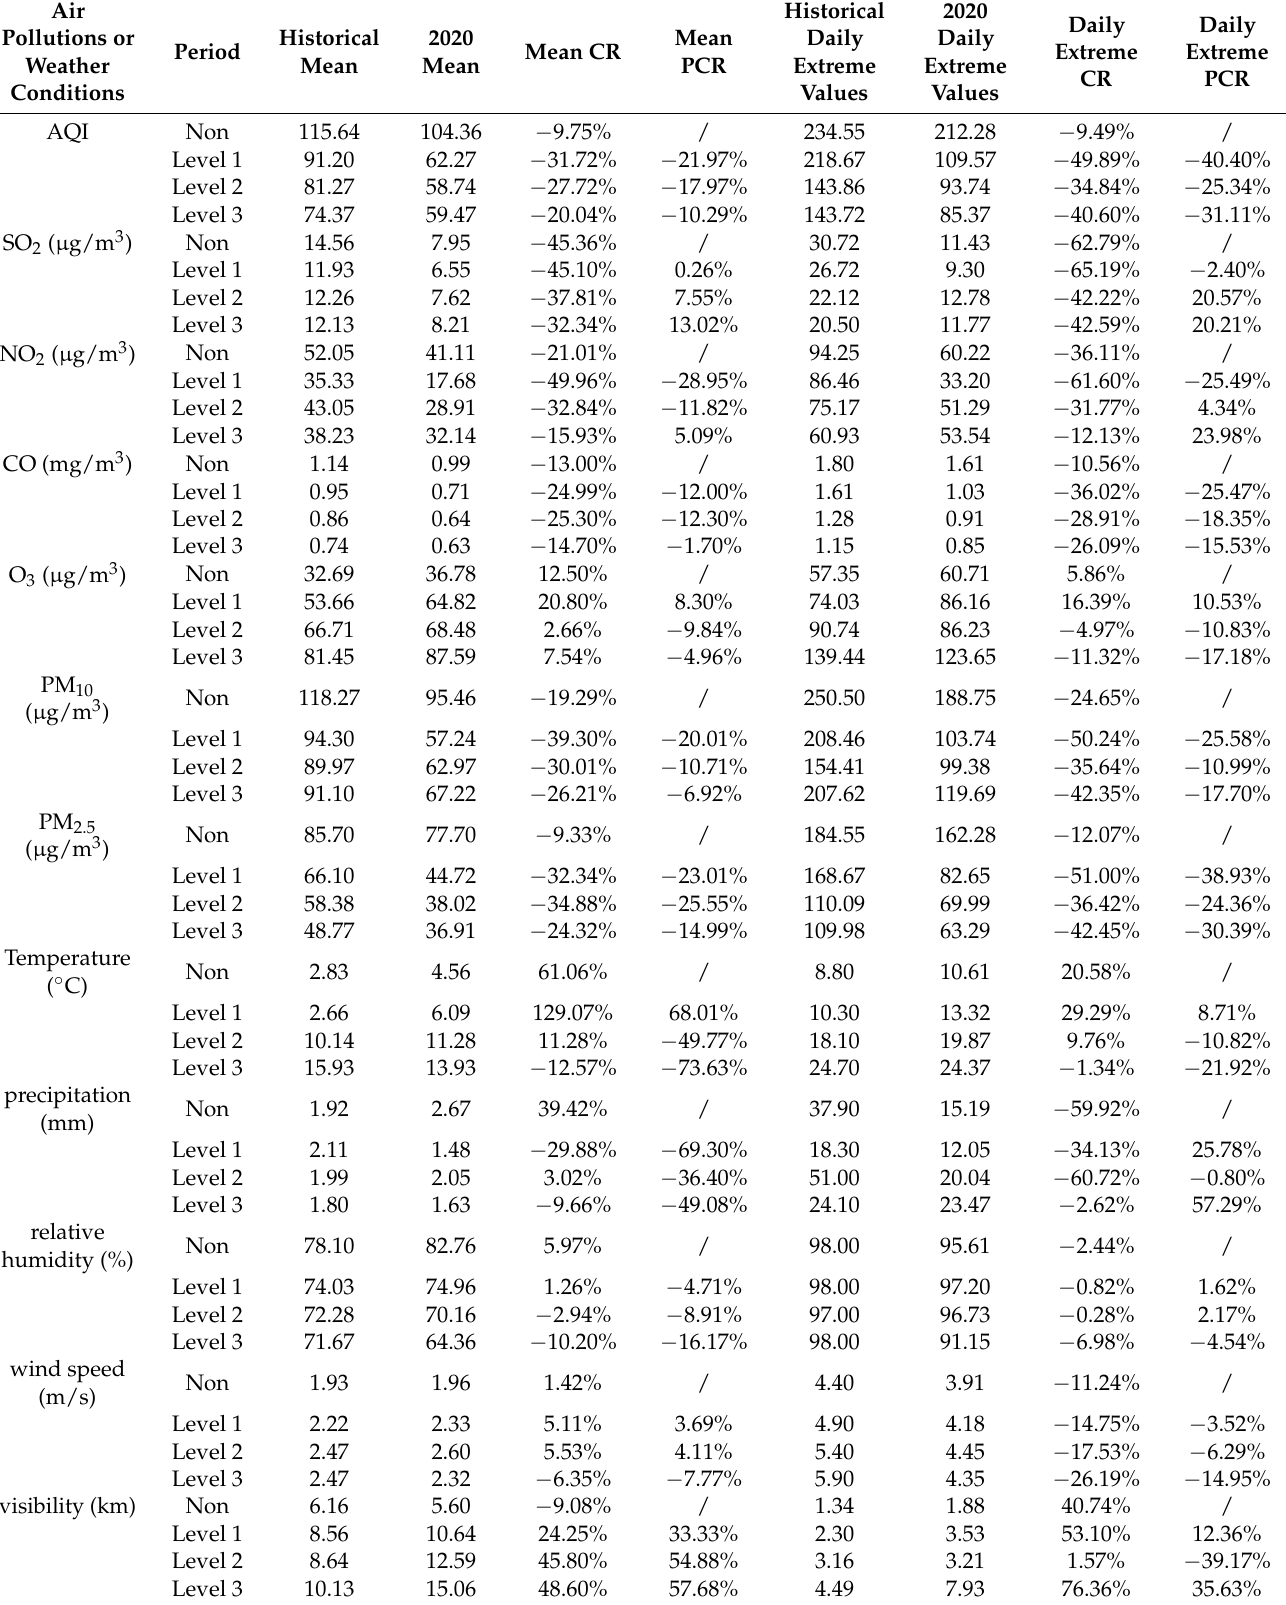
Table 3. Variations of AQI, atmospheric pollutants and meteorological conditions during the pan- demic period and the same period of previous